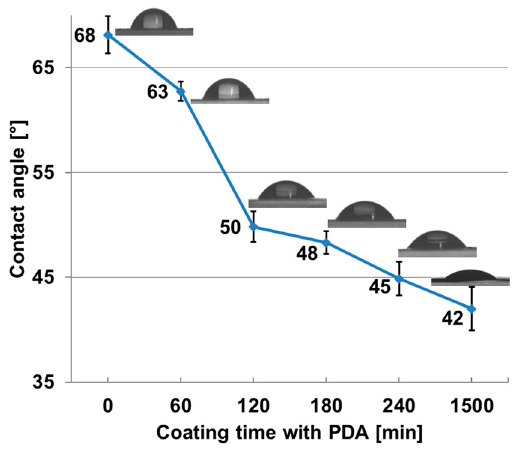
Figure 8. Contact angle and snapshots of a pure PES membrane and PES membranes after different coating time with polydopamine.